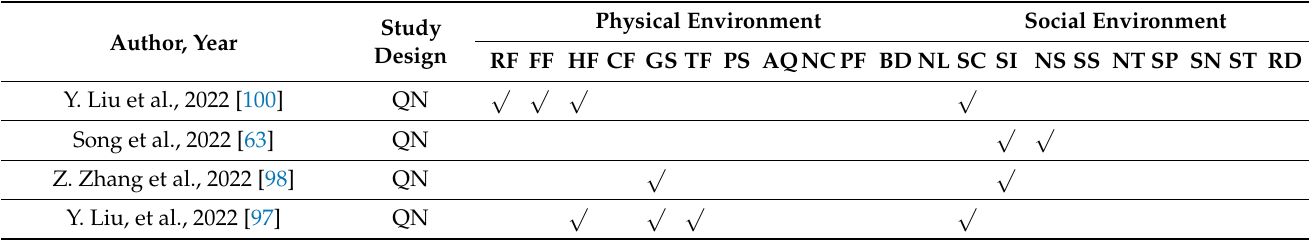
Table 5. Neighbourhood environment, migrants’ health and well-being included in the